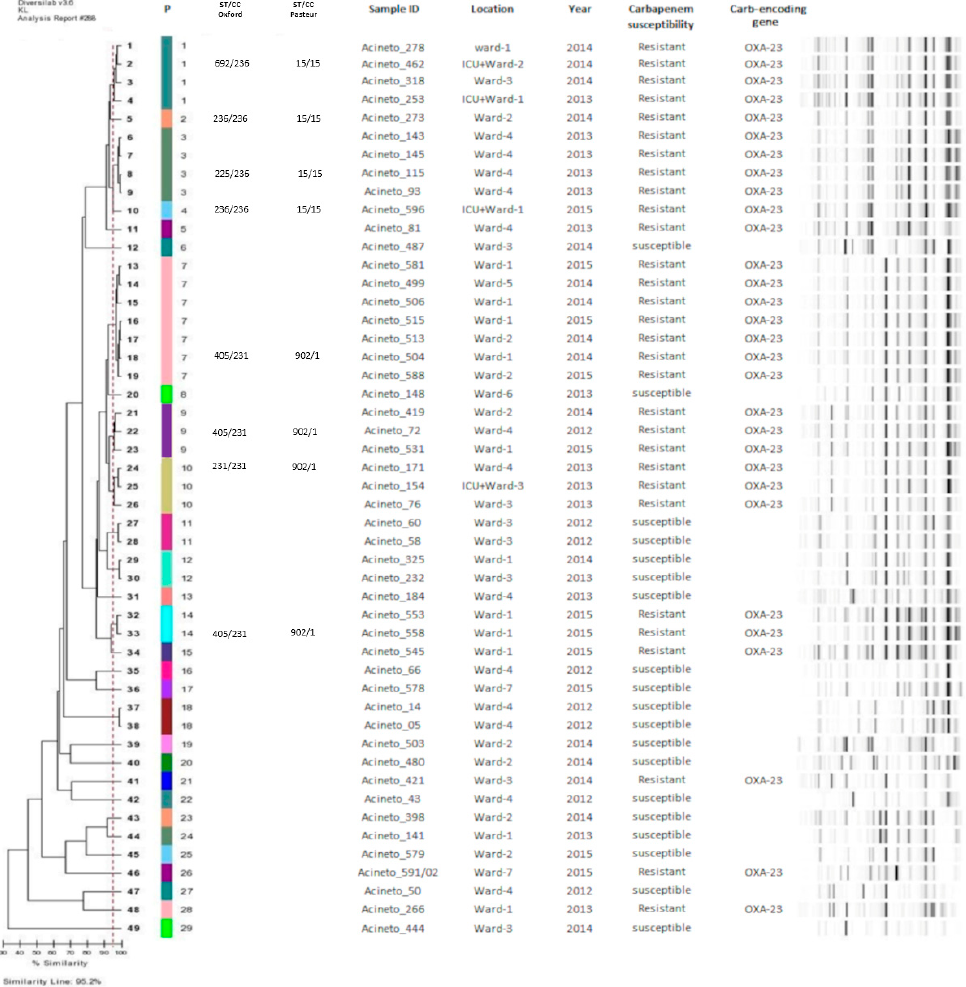
Figure 1. Dendrogram of A. baumannii isolates analysed in the study. Abbreviations: P: Patterns ( ≥ 95% similarity), ST: sequence type, CC: clonal complexes. Sample ID: Identification of A. baumannii isolates obtained from surgical site of caesarean section patients. Location: Obstetric wards in which women remained after caesarean section